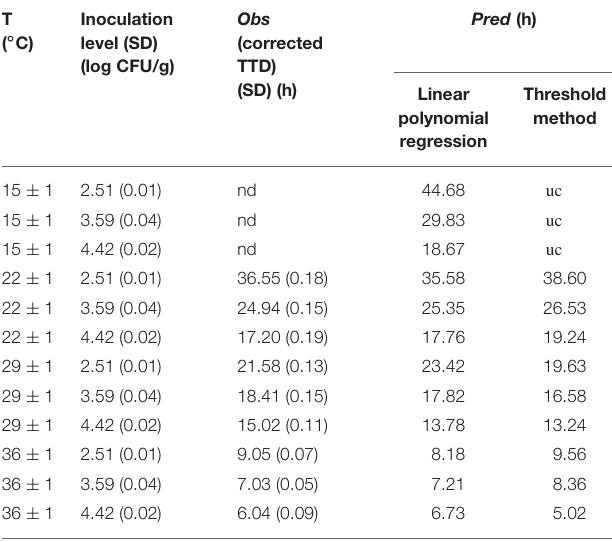
TABLE 4 | Observed and predicted TTD of SEA under combined conditions for internal